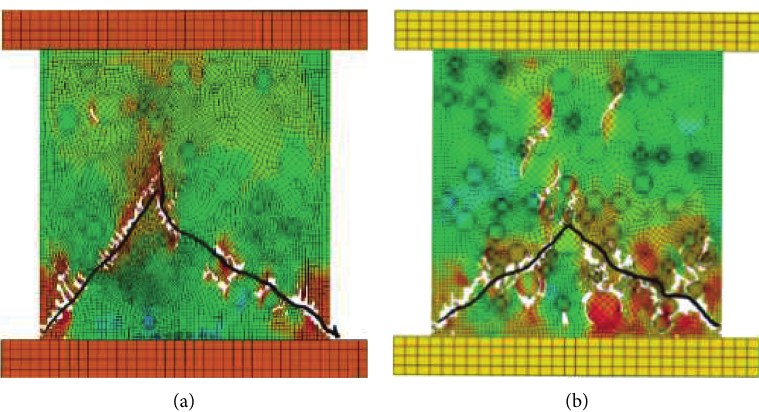
Figure 10: Simulated results of impact failure morphology of desert sand concrete and two-gradation concrete. (a) Desert sand concrete. (b) Two-graded